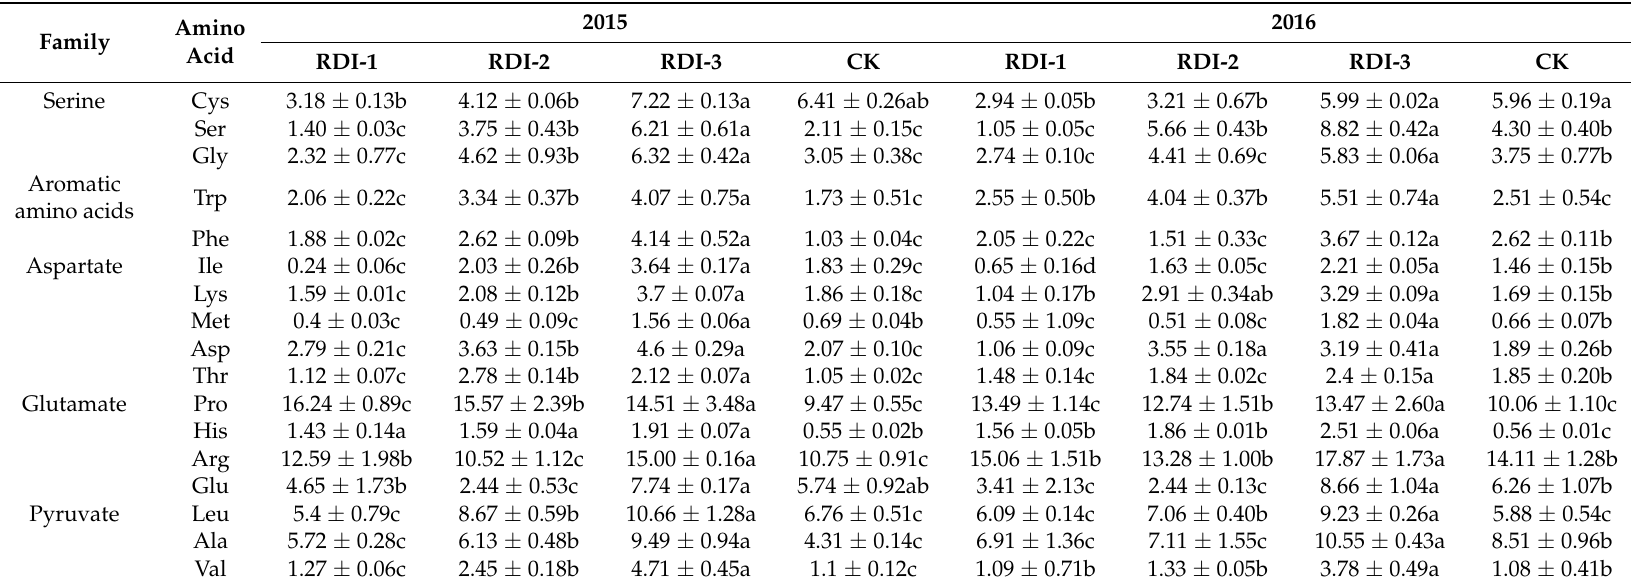
Table 3. Amino acid concentrations (mg/L) in wines from untreated (CK) and treated